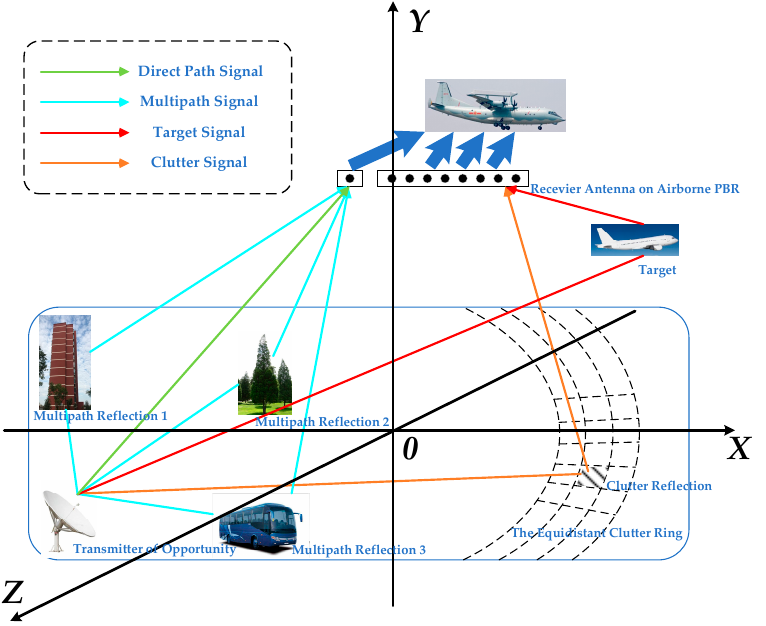
Figure 1. A typical airborne PBR detection system.